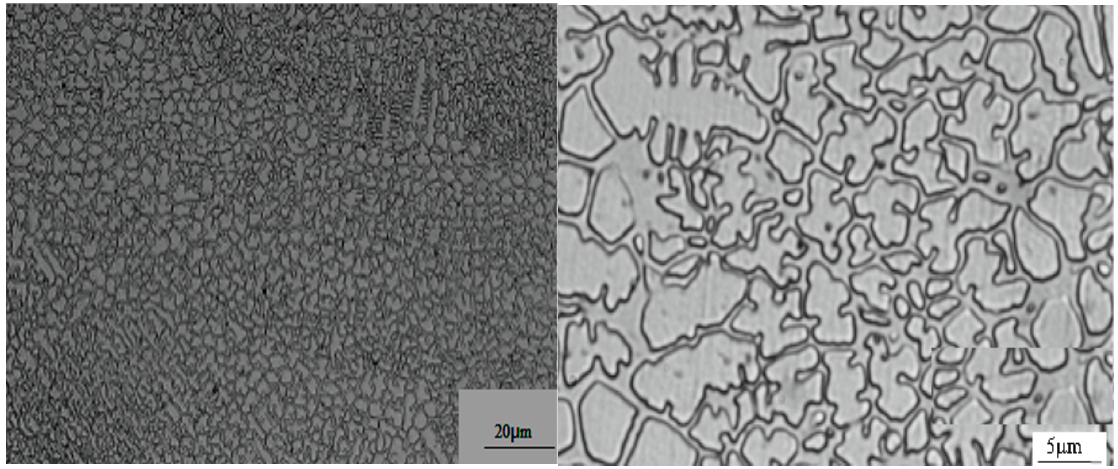
Figure 5. Surface micrographs of the Co ‐ based laser cladding coating.